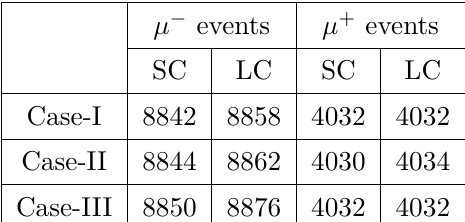
Table 3 . The total number of reconstructed µ − and µ + events expected at the 50 kt ICAL detector in 20 years for the cases I, II, and III. The SC (LC) scenario corresponds to ∆ R ( +500 km). The number of reconstructed events for the standard CMB is 8850 (4032) for µ − ( µ + ). We use the three-flavor neutrino oscillation parameters given in table 2, where we assume NO and sin 2 θ = 23